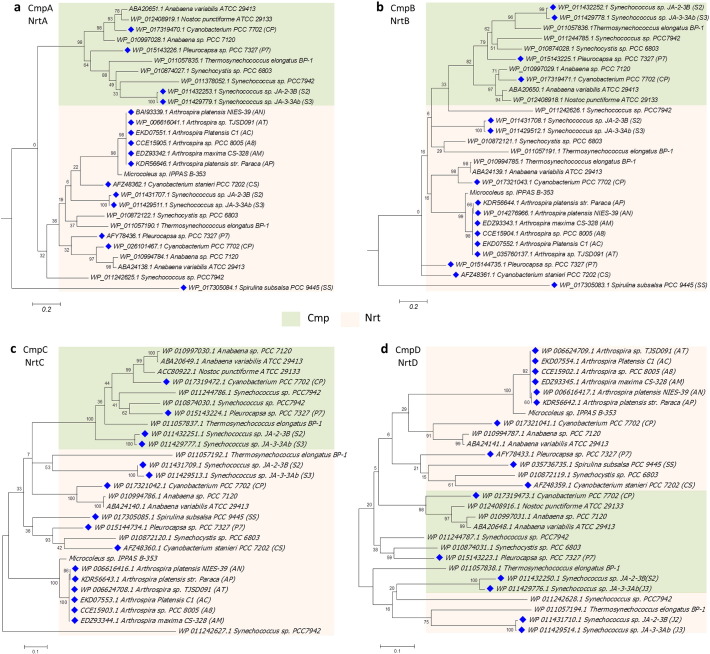
Phylogenetic trees of the CmpABCD proteins and NrtABCD proteins of the selected alkaliphilic cyanobacteria. The outgroup cyanobacteria includes Synechococcus sp. PCC 7942, which has an experimental study of HCO3− transporter BCT1 and nitrite/nitrate transport system, NRT [12]. (a) Phylogenetic tree based on the CmpA and NrtA protein sequences. (b) Phylogenetic tree based on the CmpB and NrtB protein sequences. (c) Phylogenetic tree based on the CmpC and NrtC protein sequences. (d) Phylogenetic tree based on the CmpD and NrtD protein sequences. The alkaliphilic cyanobacteria are identified by the blue diamond, respectively. Cmp and Nrt families are highlighted in orange and green, respectively. Bootstrap values with 3000 replicates are shown at the nodes of the tree. The scale bars indicate the number of nucleotide substitutions per site.